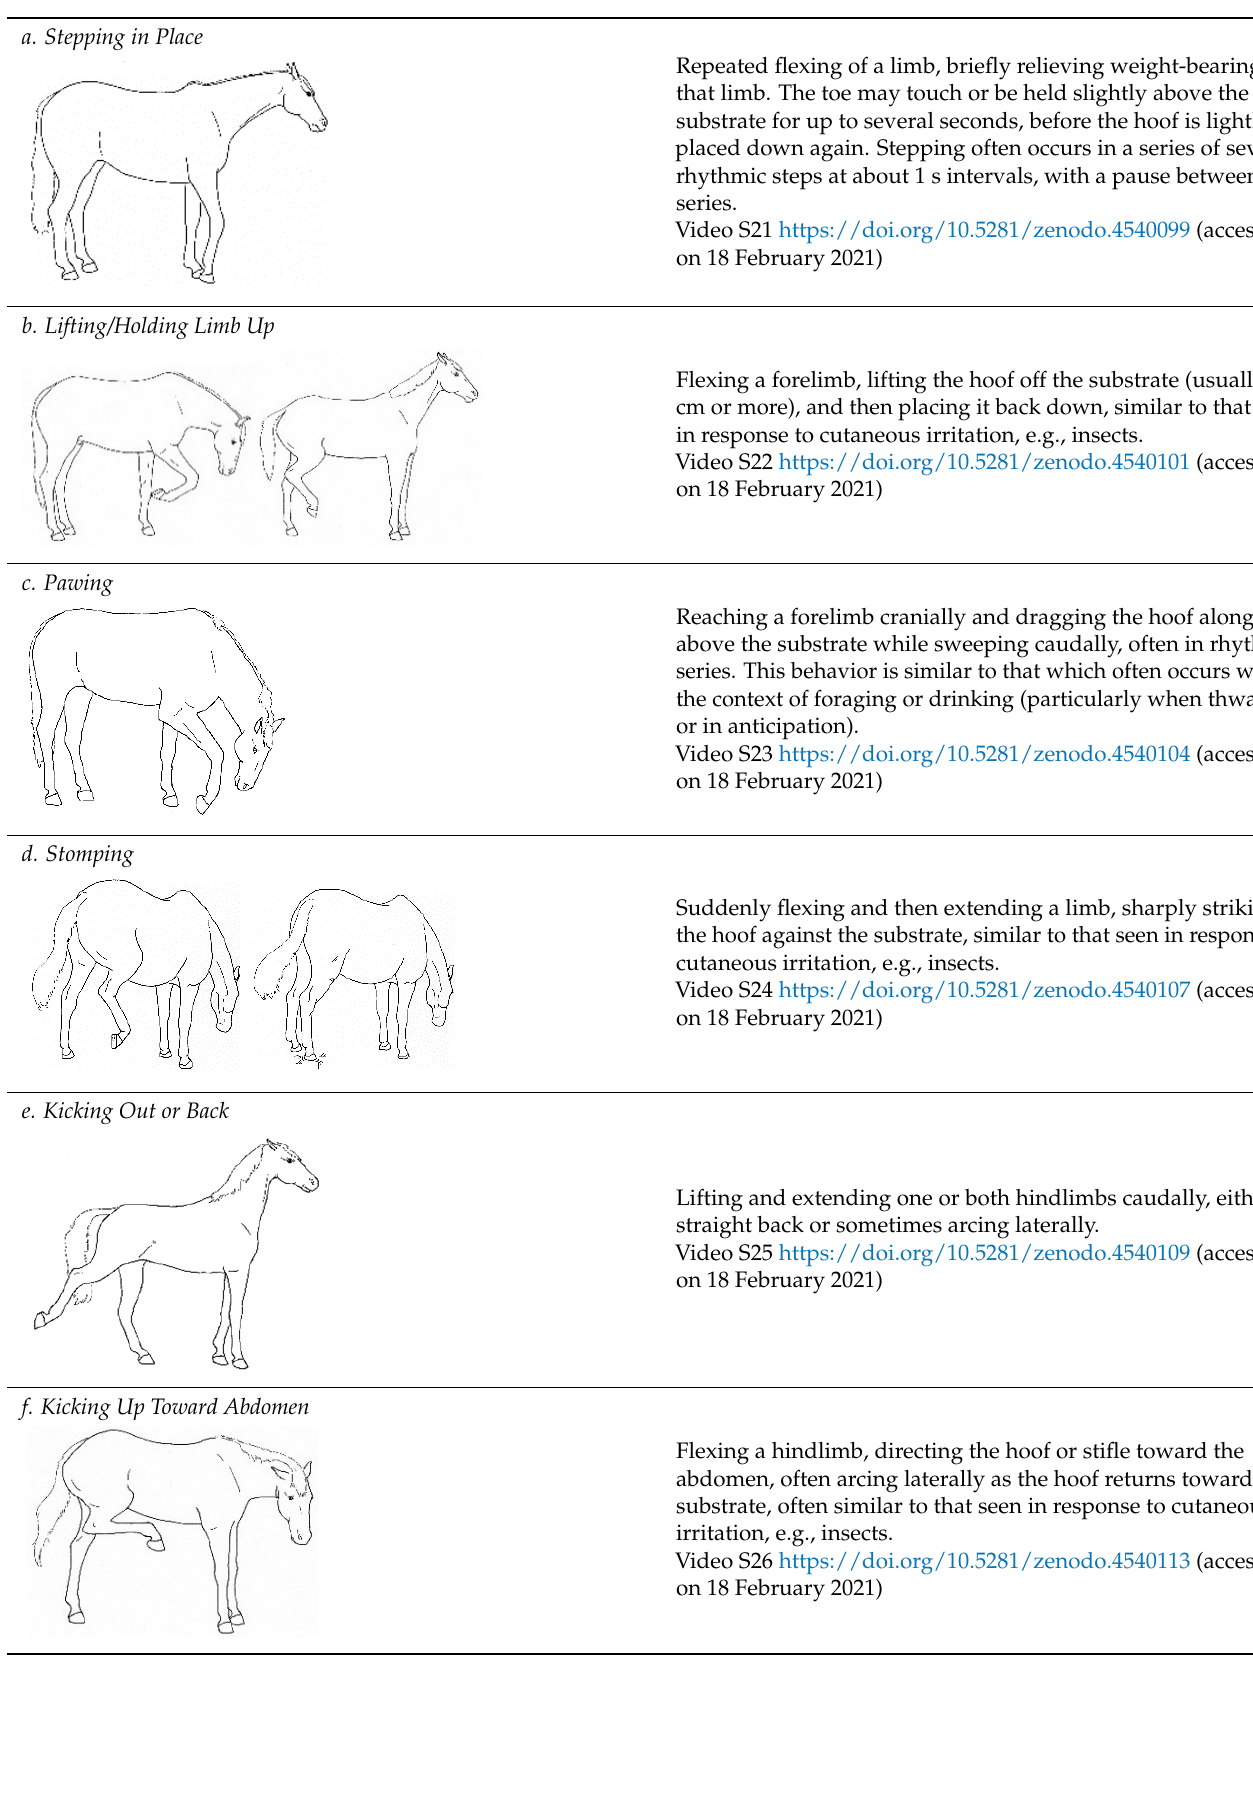
Table 2. Limb and body movements.